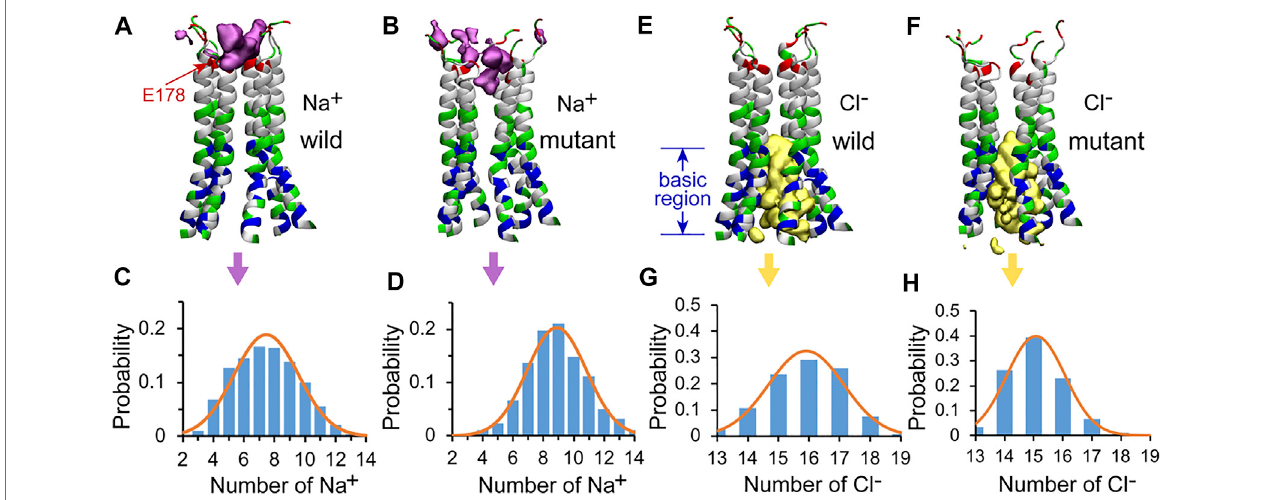
FIGURE 5 | The distributions of Na + and Cl − in the pore of the channel. The isosurface of Na + ion density in the WT (A) and the L210F mutant (B) channels. The number of Na + ions and corresponding probability in the pore of the WT (C) and the L210F mutant (D) channels. The isosurface of Cl − ion density in the WT (E) and the L210F mutant (F) channels. The number of Cl − ions and corresponding probability in the pore of the WT (G) and the L210F mutant (H) channels. The isosurface of Na + and Cl − ion densities are shown in pink and yellow with isosurface values of 0.02 and 0.06, respectively. Only residues from W148 to D184 are shown with NewCartoon and colored by residue types for clarity. Blue, basic residues; red, acidic residues; green, polar residues; white, nonpolar residues. From residue W148 to D184 along the central axis of the pore, the number of Na + and Cl − ions within a cylinder of 10-Å radius were calculated using VMD for the last 200 ns of all three trajectories for each protein